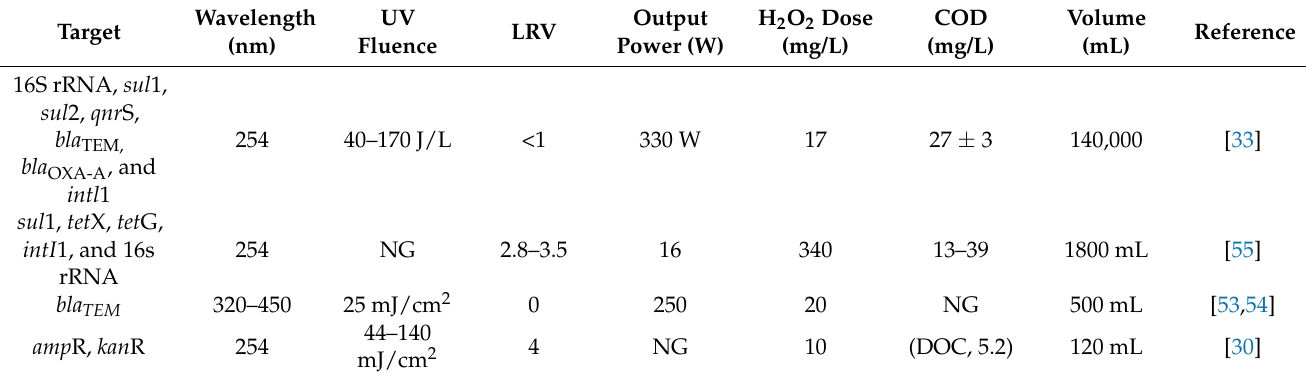
Table 3. Inactivation of ARGs by UV/H 2 O 2